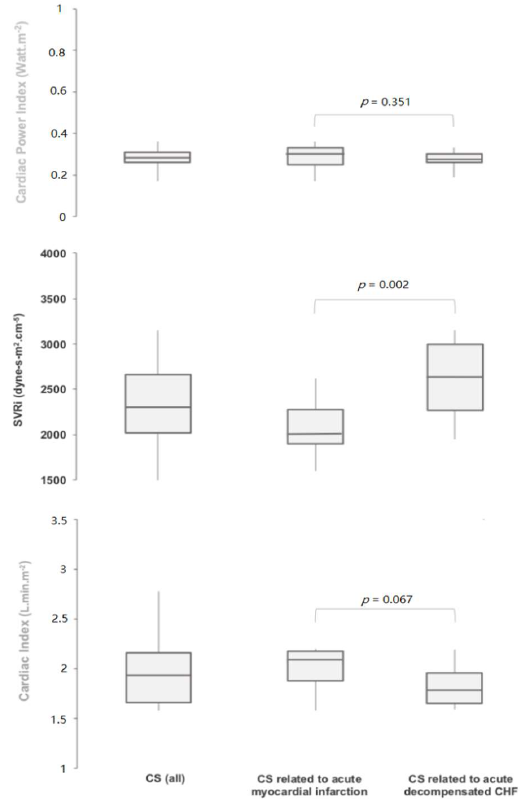
Figure 2. Hemodynamic profile on admission. CHF, Chronic heart failure; CS, Cardiogenic shock; SVRi, Systemic vascular resistance index.